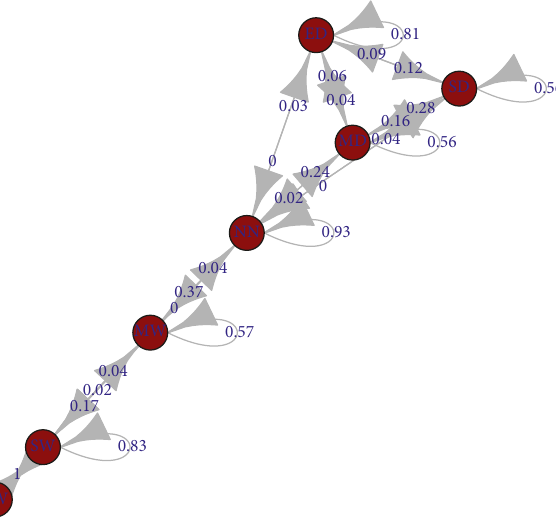
Figure 5: Transition behavior of drought classes at Astor station. Table 2: Squared Kappa and weights at various time lags at Astor station.